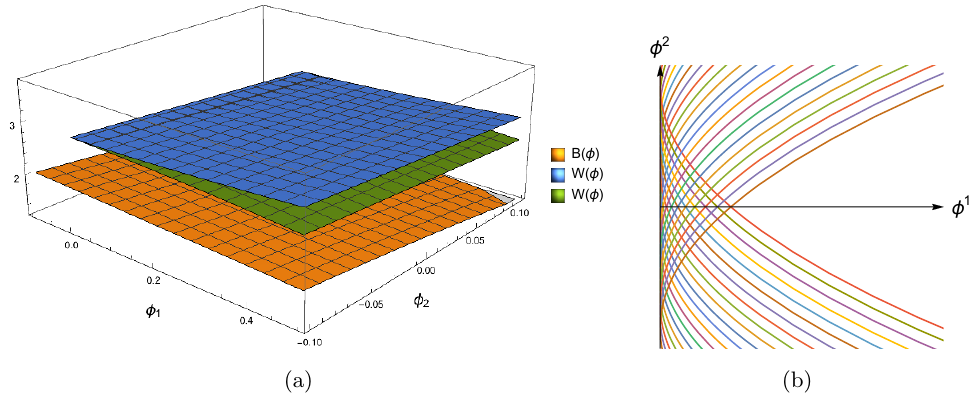
Figure 7 . Figure (a) represents in yellow the curve B ( (cid:30) ) and a two-branched superpotential W in green and blue. B ( (cid:30) ) is associated with the potential V ( (cid:30) ) through equation (3.3). The plot is in the linear regime (3.71) with parameters V 0 = (cid:0) 1, V 1 = 0 : 44, V 2 = 3 : 31. The two branches of W ( (cid:30) ) are given by equations (3.72) and (3.73). The upper branch of the superpotential corresponding to the + sign in (3.72) is in blue and the lower branch of W is in green. Figure (b) shows the (cid:13)ow lines around a bounce, from equation (3.74), di(cid:11)ering by the choice of (cid:30) 1 . Even though no individual 0 line is self-intersecting, the ensemble of the (cid:13)ow lines gets superposed after the bounce. The similarity with the single-(cid:12)eld case and with the complete bounces of the